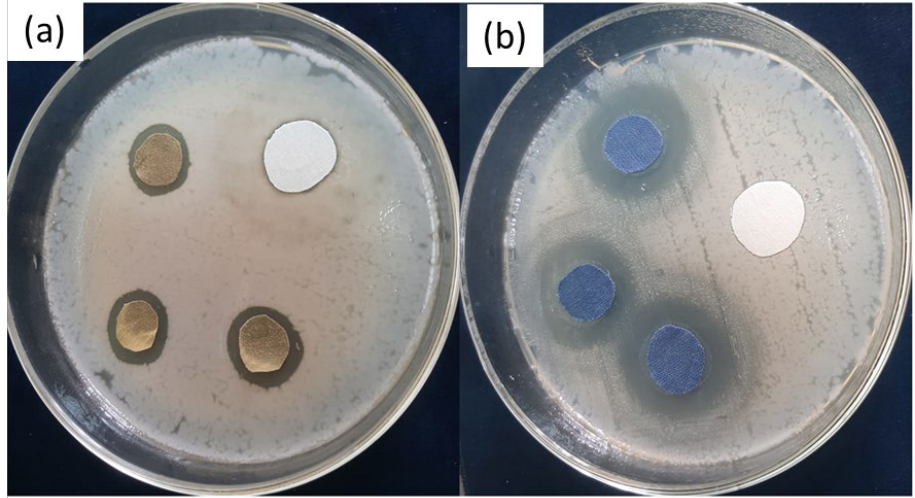
Figure 9. ZOI around ( a ) copper-coated fabrics and ( b ) copper-coated dyed fabrics against E-coli.